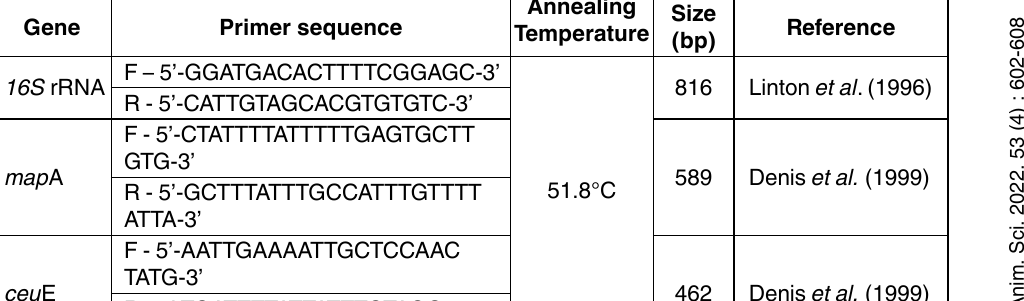
table 2. Details of primers and product size